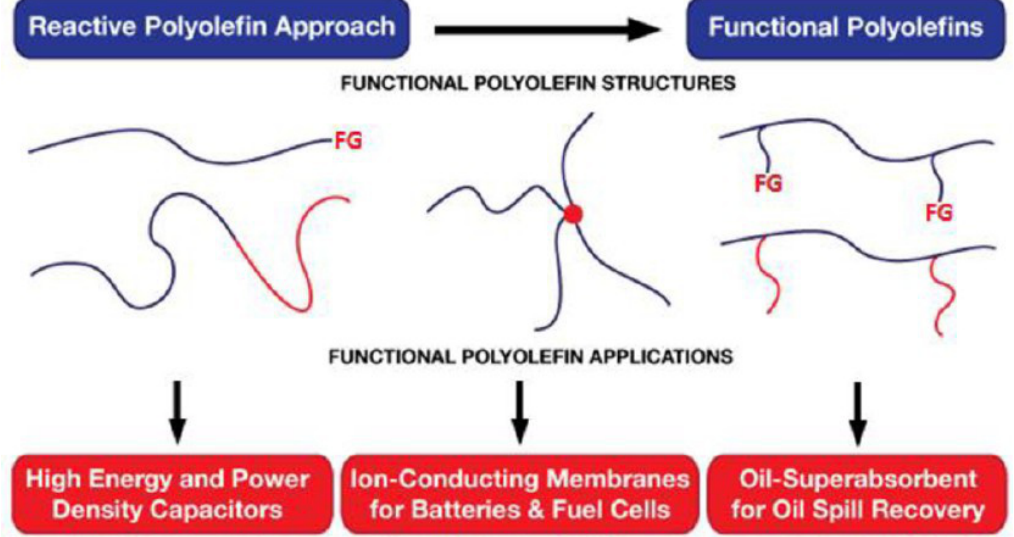
Figure 3. Functional polyolefins for energy applications. Adapted with permission from [2]. Copyright 2013